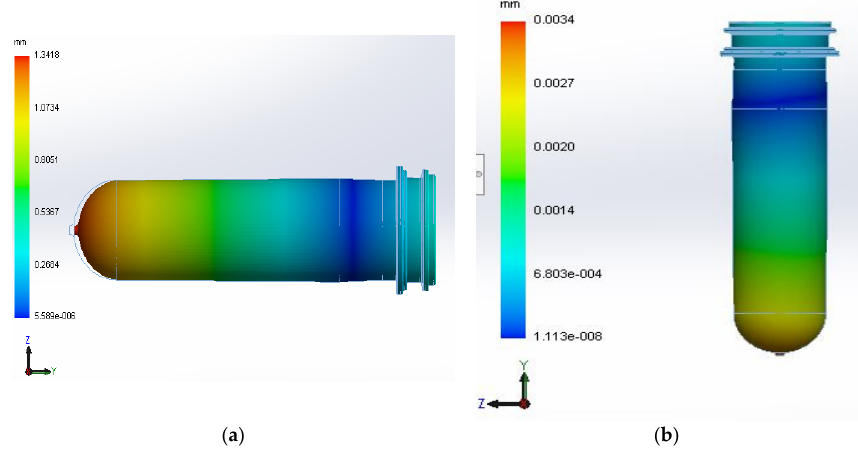
Figure 10. ( a ) Warpage contours of PET preform. ( b ) In-mold residual stress displacement. Processes 2023 , 11 , 414